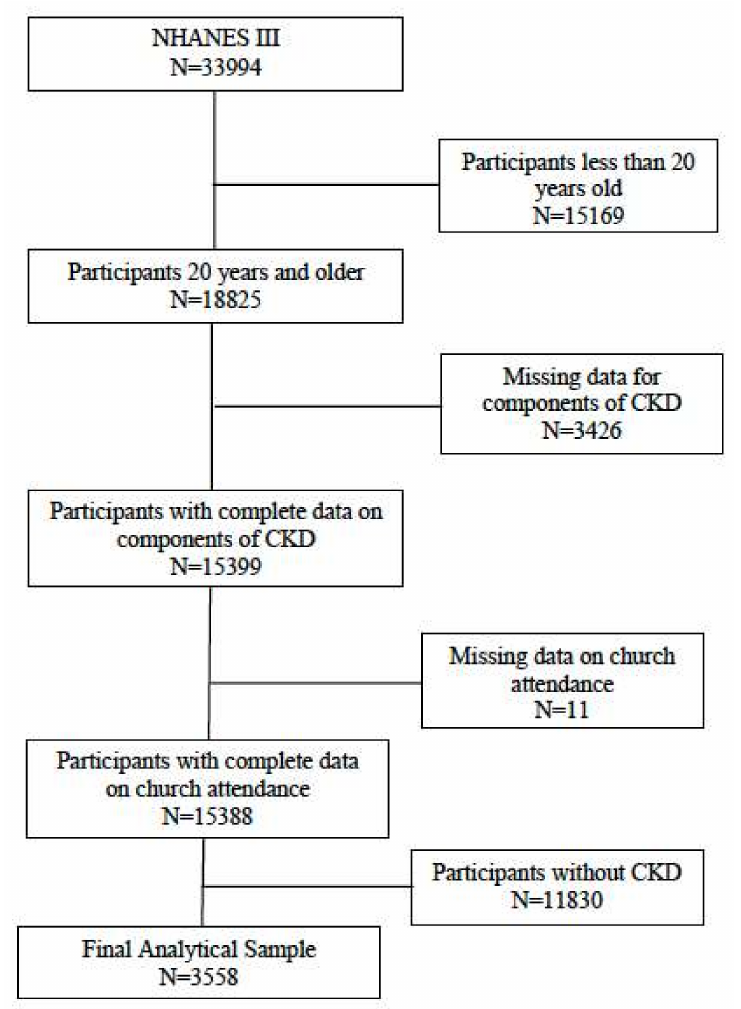
Figure 3. Study Cohort Flow